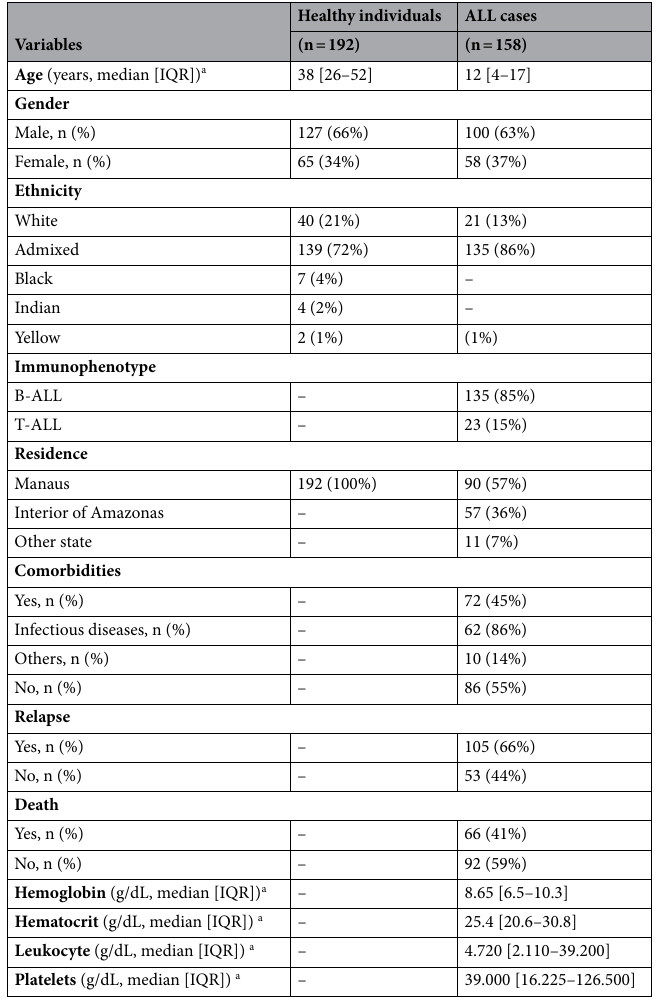
Table 1. Selected characteristics of the childhood leukemia and controls in the Brazilian Amazon. a g/ dL = Gram per decilitre. IQR = Interquantile